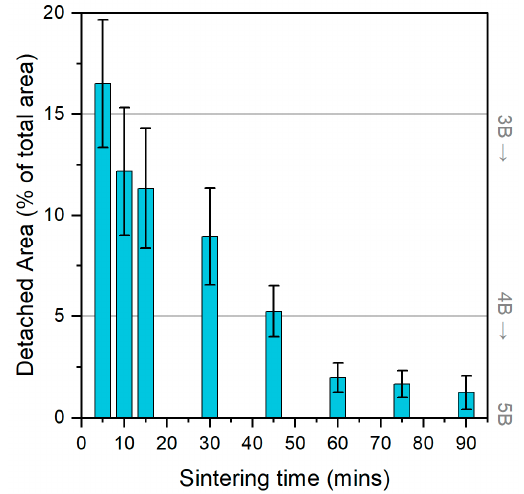
Figure 6. Representation of the adhesion evaluation in terms of the detached area as a percentage of the total printed area (15 × 15 mm 2 ) for the silver nanoparticle-based ink. The right y-axis represents the adhesion classification based on the F1842-15 standard, starting from 5B to 4B and 3B in this set of experiments.